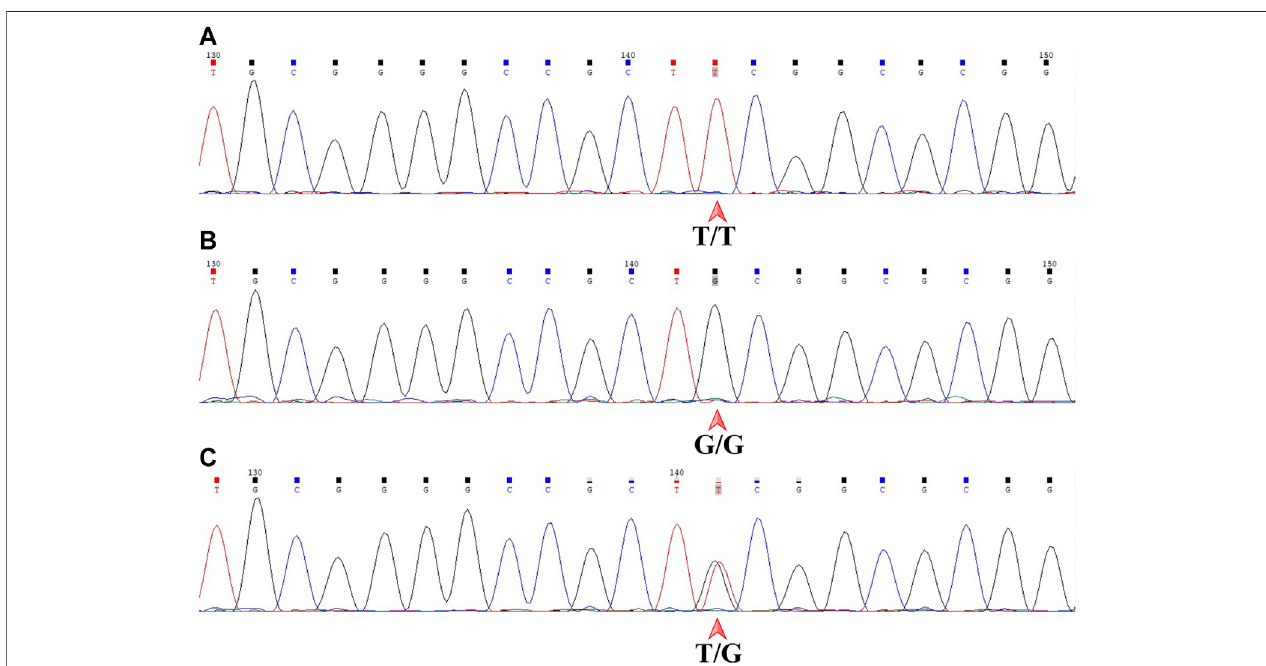
FIGURE 4 | Sanger DNA sequencing of the 359-base pair DNA fragment in a forward read. MDM2 SNP309 is downstream of 5 ′ -CCGCT-3 ’ . (A) T/T shown by a singleredpeak. (B) G/Gshownbyasingleblackpeak. (C) T/Gshownbyoverlappingredandblackpeaks. MDM2,mousedoubleminute2gene;SNP,single-nucleotide polymorphism.